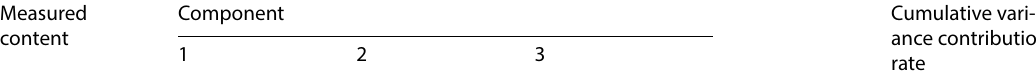
Table 4 The rotated component